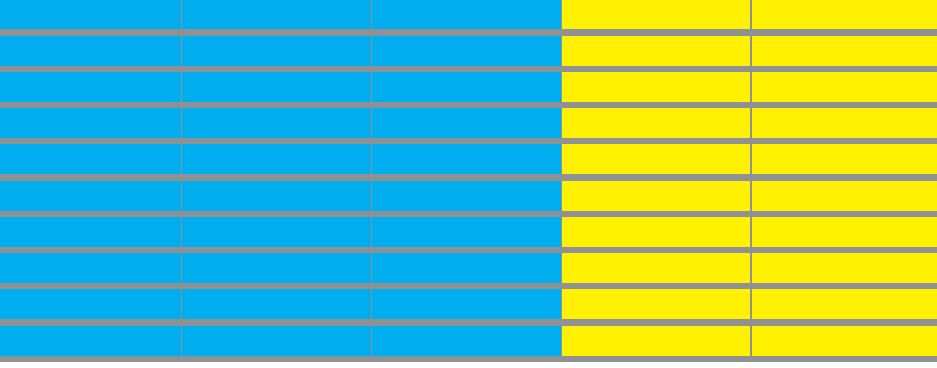
Fifty voting precincts are to be apportioned into ten contiguous districts. Each precinct is dominated by either the Cyan or the Yellow party and each precinct has approximately the same voting population. In this plan Cyan has a strong majority in each of the 10 districts, suggesting a partisan gerrymander in favor of